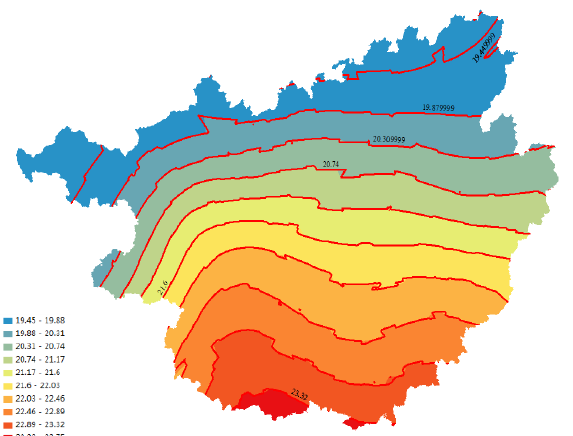
Figure 1. Original TM Remote Sensing Image in Guangxi (Tao, Figure 4. Distribution of temperature data in Guangxi Province 2013)